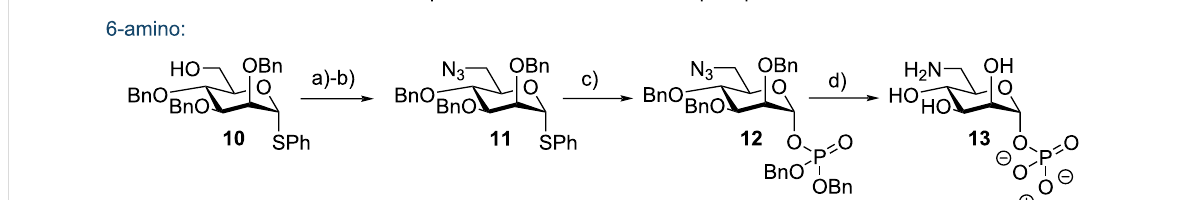
use these optimised MacDonald conditions to directly access 17 from 14 , but the reaction exhibited extensive degradation upon multiple